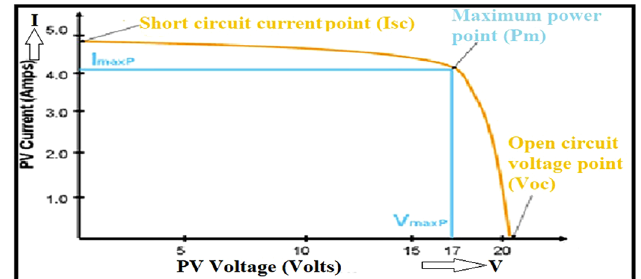
Fig. 1. Photovoltaic module voltage –